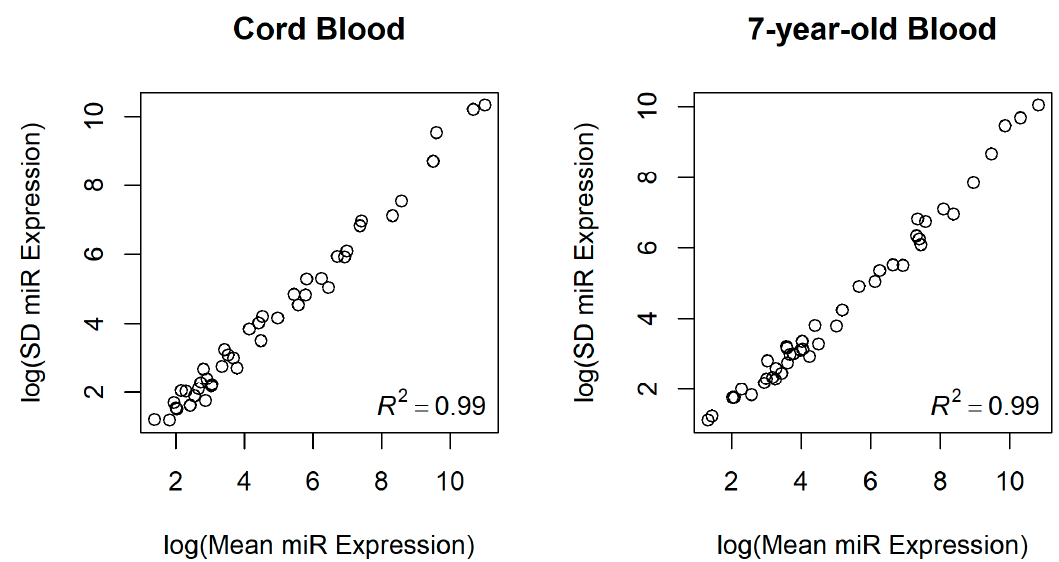
Figure 1. Scatter plot of mean miRNA expression levels and standard deviation of miRNA expression levels in newborns and 7-year-old children. Log mean miRNA expression levels and log standard deviation of miRNA expression levels were highly correlated among the 43 miRNAs interrogated by NanoString. SD: standard deviation.